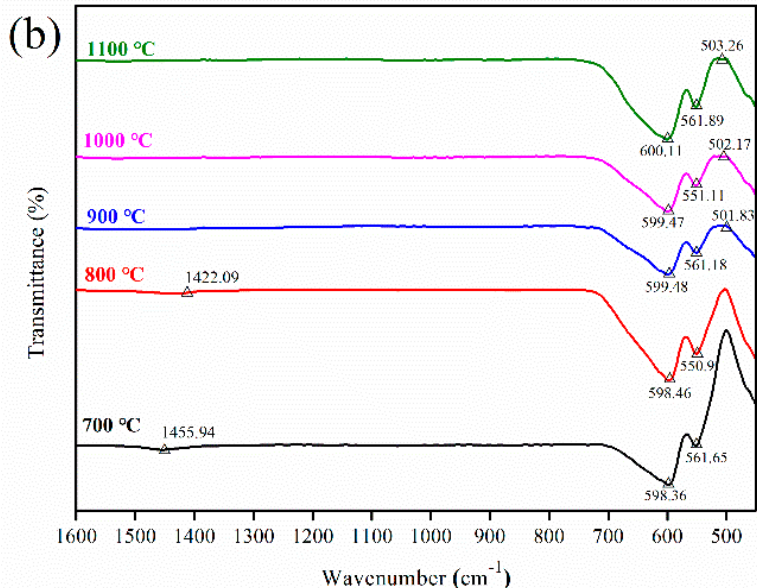
Figure 3. Analyses of untreated and heat-treated samples: ( a ) XRD patterns and ( b ) FTIR spectra. The main crystal phase of the untreated sample was observed to be γ -Fe 2 O 3 , whereas the main crystalline phases of the sample annealed at 400 °C are SrFe 12 O 19 and α -Fe 2 O 3 . This indicates that the following reaction occurs during the annealing process.